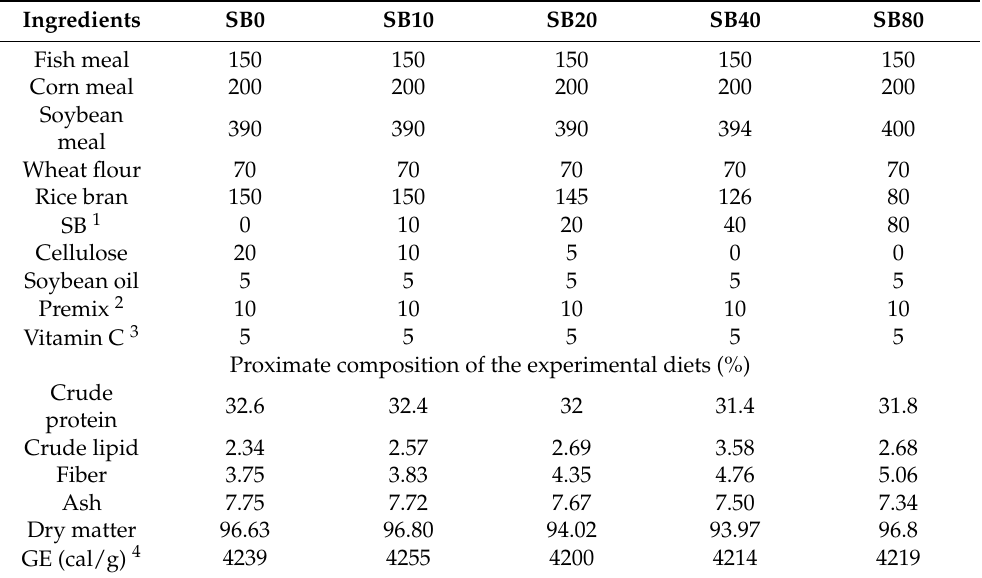
Table 1. The formulation and proximate composition of the experiment (g kg − 1